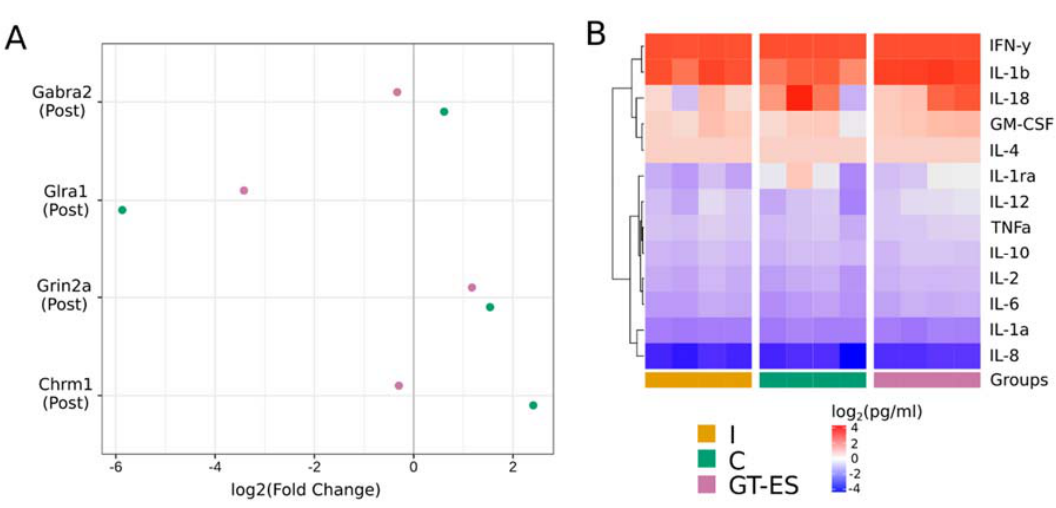
Figure 8. Cytokines profiling and synaptic gene expression in the spinal cord at 60 days after SCI. ( A ) Comparison of target genes expression. The results are represented as an average log2(fold change) in control (C, green points) and treated (GT-ES, pink points) pigs relative to the expression level in the intact group. Threshold cycles (Ct) were obtained for two animals (two repeats per animal) in each group and normalized by corresponding Gapdh values. ( B ) Heatmap representing a log-transformed cytokines absolute concentration in spinal cord samples, where each column represents tissue samples (two samples per animal). Columns are bunched by experimental groups (I, C, and GT ‐ ES). Cytokines are ordered by the results of hierarchical agglomerative clustering.